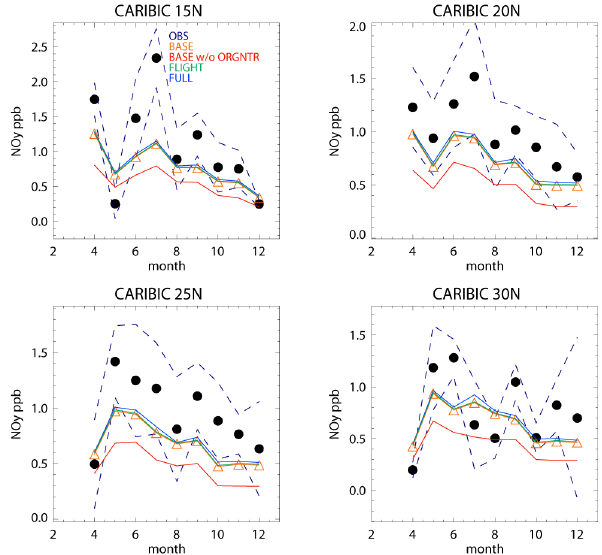
Fig. 11. A comparison of CARIBIC NO y measurement data (black) sampled in selected latitudinal bins with corresponding model out- put for the BASE (orange triangles), FLIGHT (green) and FULL (blue). Also shown is BASE NO y without the contribution from alkyl nitrates (red). The 1- σ variability in the observations is indi- cated by the dashed blue